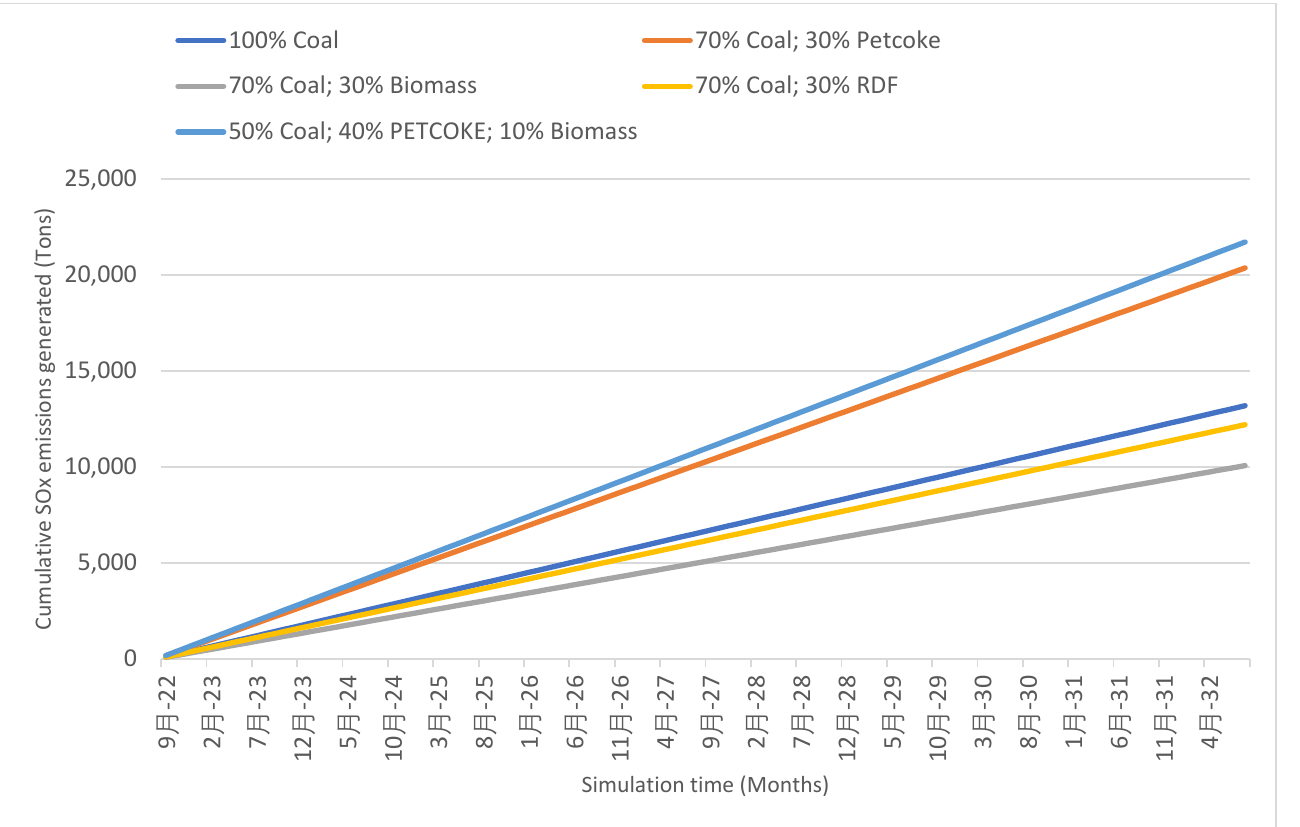
Figure 11. Cumulative SOx emissions generated from the fuel-burning system under different fuel-mix configurations.